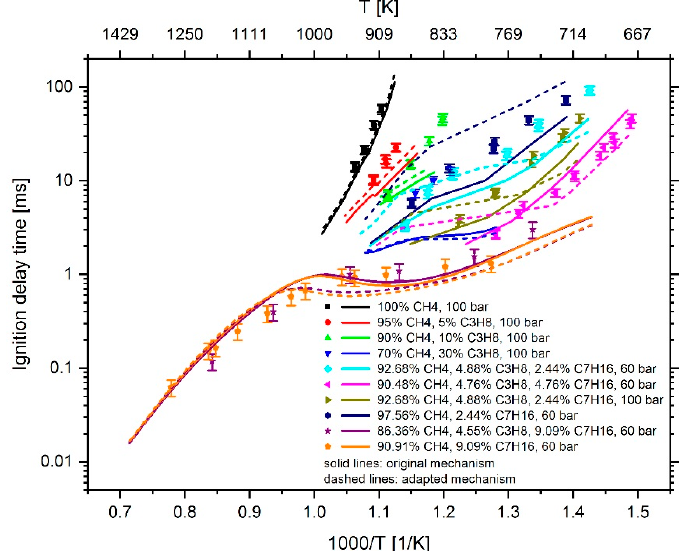
Figure 31. Experimental data (symbols) [6,7] versus model prediction (lines) using the Complete San Diego mechanism with n -heptane extension [20] before and after the mechanism adaption.